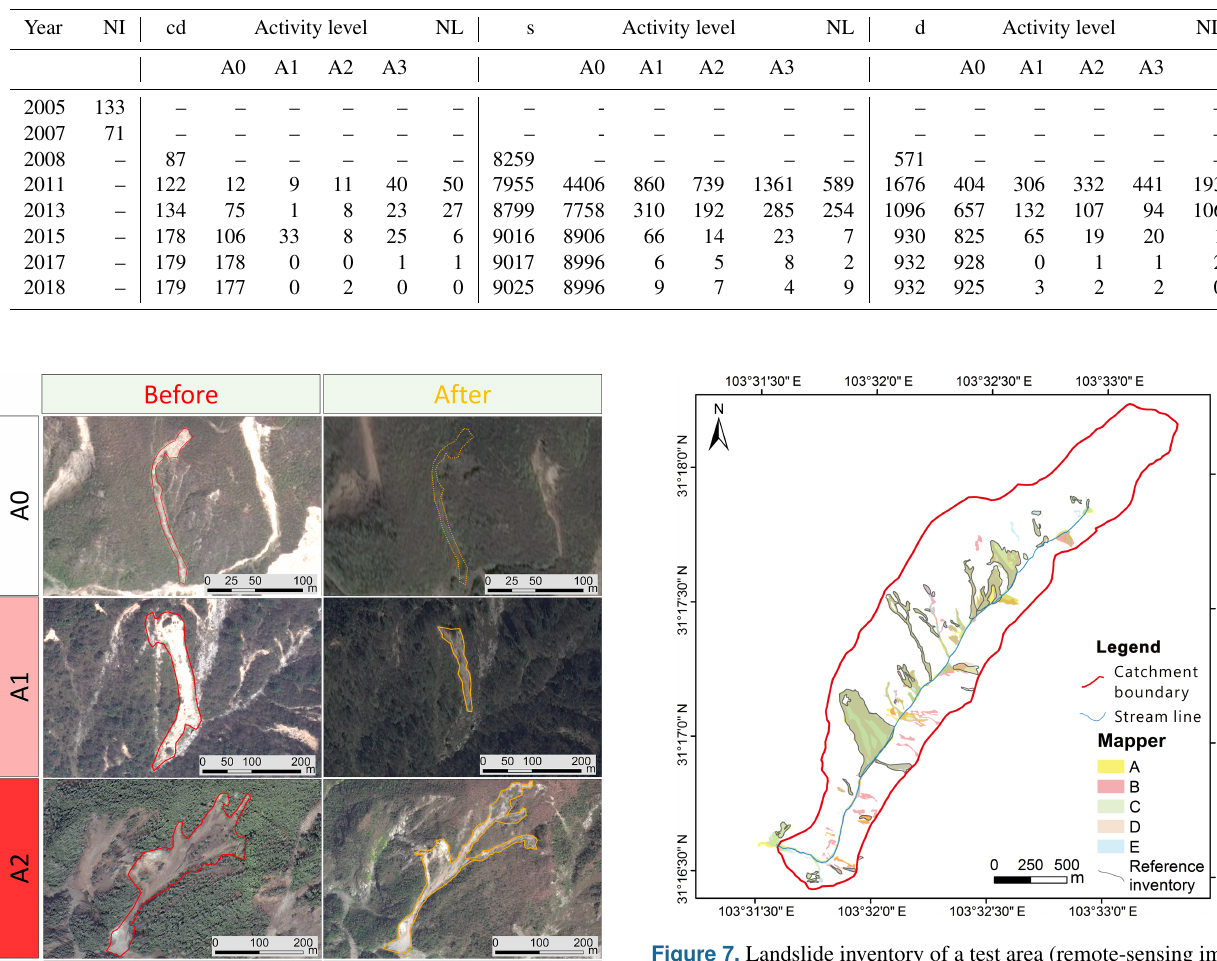
Table 2. Landslides with no information (NI), channel deposits (cd), slides ( s ), debris flows ( d ), levels of activity (A0–A3) and new landslides (NL) in the inventory.